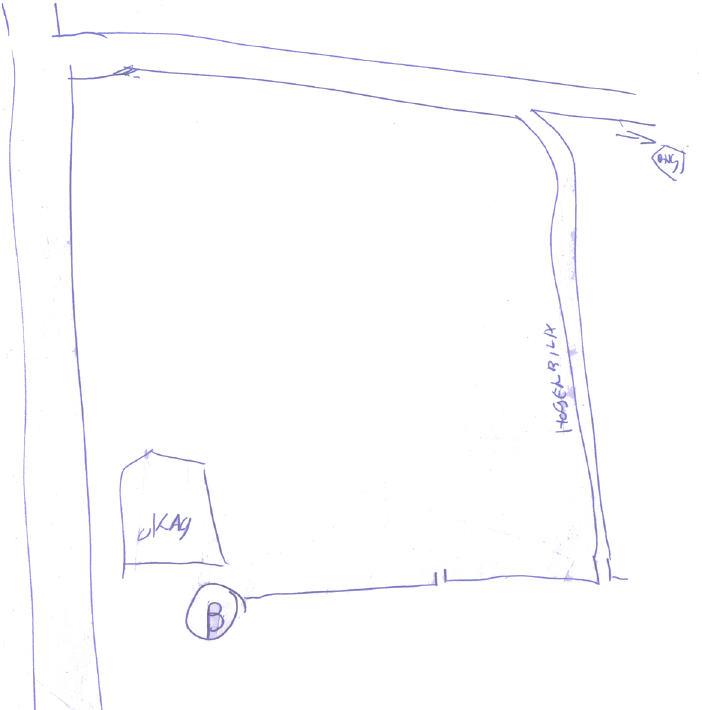
FIG. 2 Steve’s drawing highlights a big supermarket next-door and a bus stop